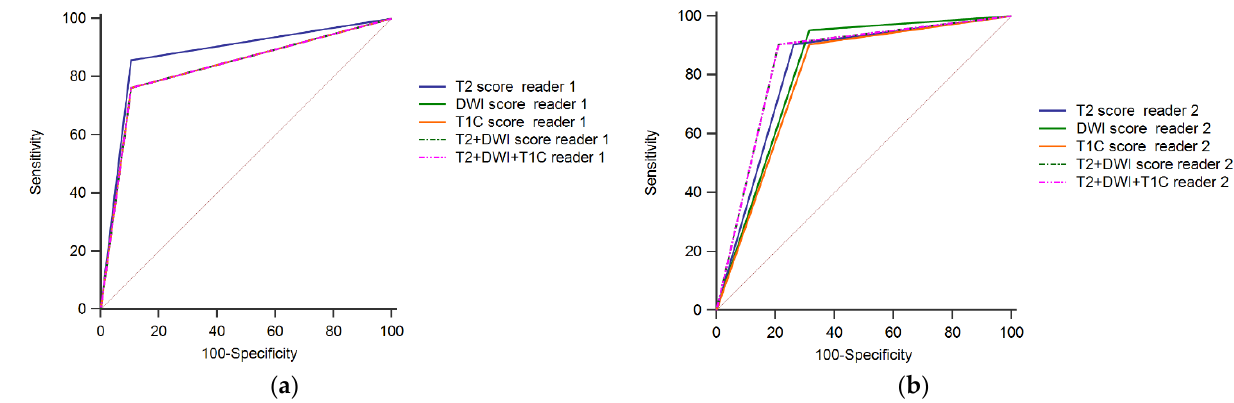
Figure 5. Receiver operating characteristics for the detection of complete response (Reader 1 — panel ( a ); Reader 2 — panel ( b )). For Reader 2, the highest values for Se and NPV were observed for DWI (95.2%, 92.9%). The combination of sequences — T2WI+DWI and T2WI+DWI+T1C — had the high- est Sp, PPV, AUCs and accuracy rates (79.0%, 82.6%, 0.847 and 85.0%, respectively), fol- lowed by T2WI score (73.7%, 79.2%, 0.821 and 82.5%). DWI had the highest Se and NPV among the sequences assessed. No significant differences for AUCs were observed be- tween MRI sequences ( p -value for the difference between individual AUC were > 0.05; Table 5, Figure 5). The accuracy rates for mrTRG were 82.5% for Reader 1 and 85.0% for Reader 2, re- spectively. The Sp and PPV of SSS for detecting CR were 89.5% and 90.0% for Reader 1, and 73.7% and 79.2% for Reader 2. Accuracy rates were 87.5% and 82.5%, respectively. 3.4. Diagnostic Performance of MRI for Detecting near-Complete Response Overall, the AUCs for both Readers were lower than those for detecting CR. For Reader 1, the highest Sp, PPV and accuracy rate were observed for T2WI (78.6%, 62.5% and 80.0%, respectively). AUC was significantly higher for T2WI than T1C, T2WI+DWI and T2WI+DWI+T1C ( p -value for this comparison <0.05) (Table 6, Figure 6).